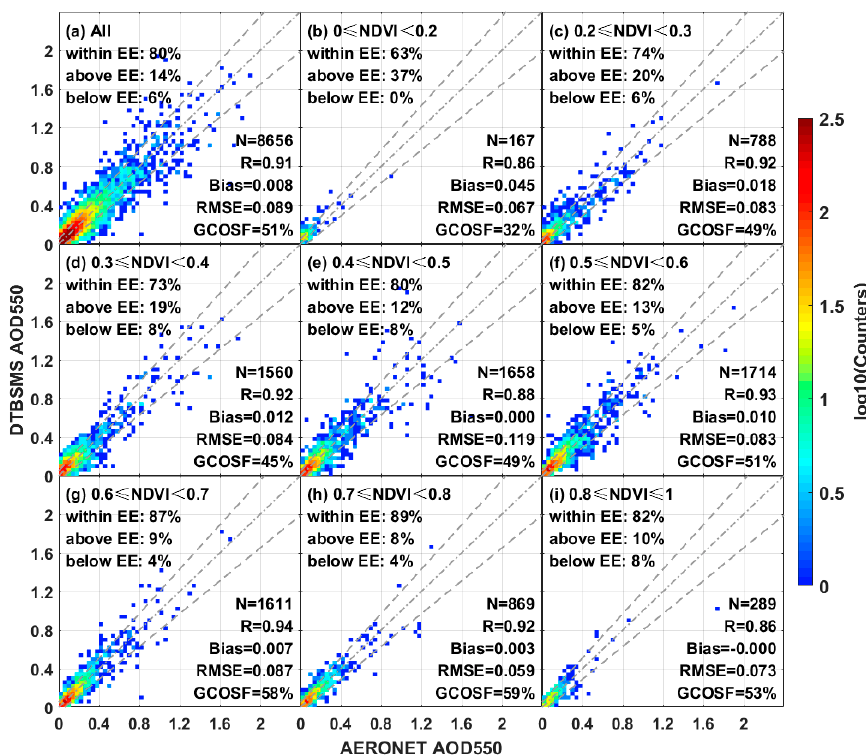
Figure 6. Global validation of merged AOD550 from Bilal’s SMS method (DTBSMS) over 422 sites worldwide using AERONET AOD550 measurements from 1 January 2017 to 31 December 2017. ( a ) The overall retrieval results of DTBSMS. ( b – i ) The retrieval results of DTBSMS under di ff erent NDVI bins. The gray solid line is the 1:1 line, and the gray dashed lines are the EE envelopes.